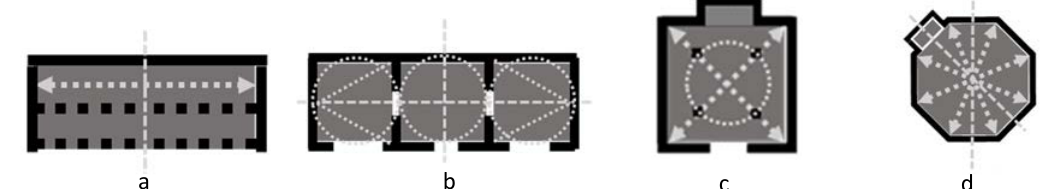
Fig. 9: Evolution of shabistan space. a- Columnar shabistan, b- Three-part shabistan, c- Gunbadkhane with a square plan, d- Gunbadkhane with an octagonal plan